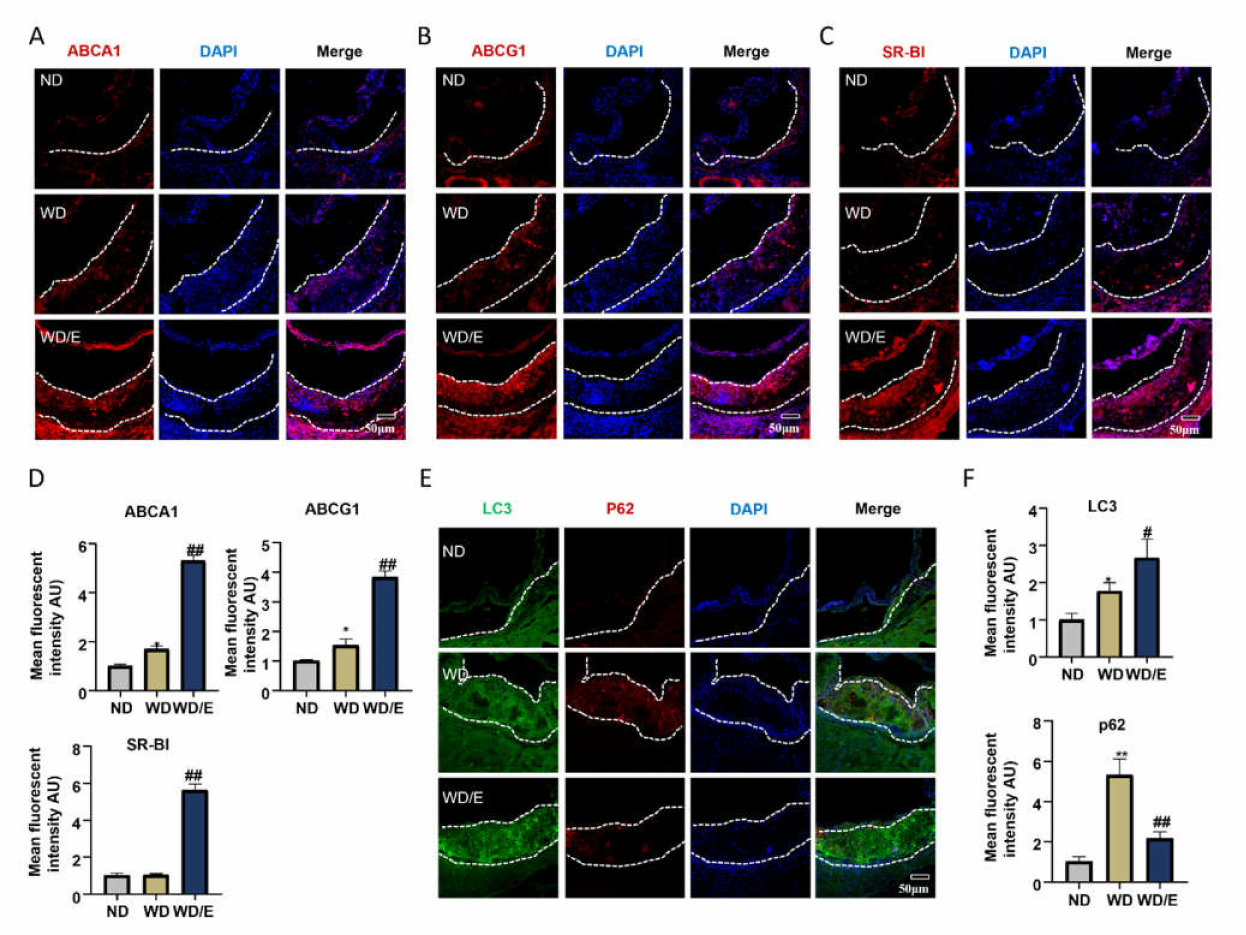
Figure 2. Exercise increases the protein levels of cellular cholesterol transporters and autophagy flux. ( A – C , E ) Representative immunofluorescence images of aortic root frozen sections from ApoE − / − mice: ( A ) ABCA1 stains (red) and DAPI nuclear stains (blue); scale bars, 50 µ m. ( B ) ABCG1 stains (red) and DAPI nuclear stains (blue); scale bars, 50 µ m. ( C ) SR-BI stains (red) and DAPI nuclear stains (blue); scale bars, 50 µ m. ( E ) LC3 stains (green), p62 stains (red), and DAPI nuclear stains (blue); scale bars, 50 µ m. ( D , F ) Quantification of immunofluorescence images (n = 6). Data are represented as means ± SEM. * p < 0.05, ** p < 0.01 vs. ND mice; # p < 0.05, ## p < 0.01 vs. WD